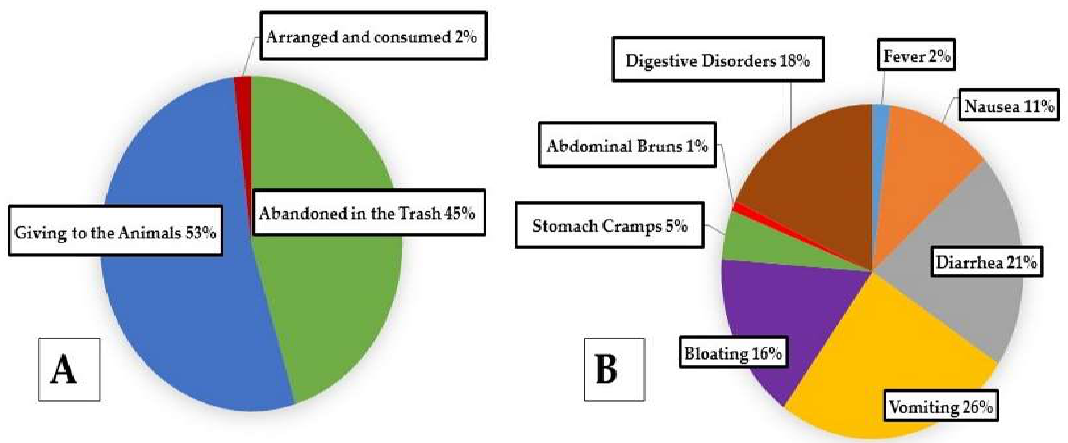
Figure 6. Management of altered Milk ( A ) and Clinical Signs ( B ).